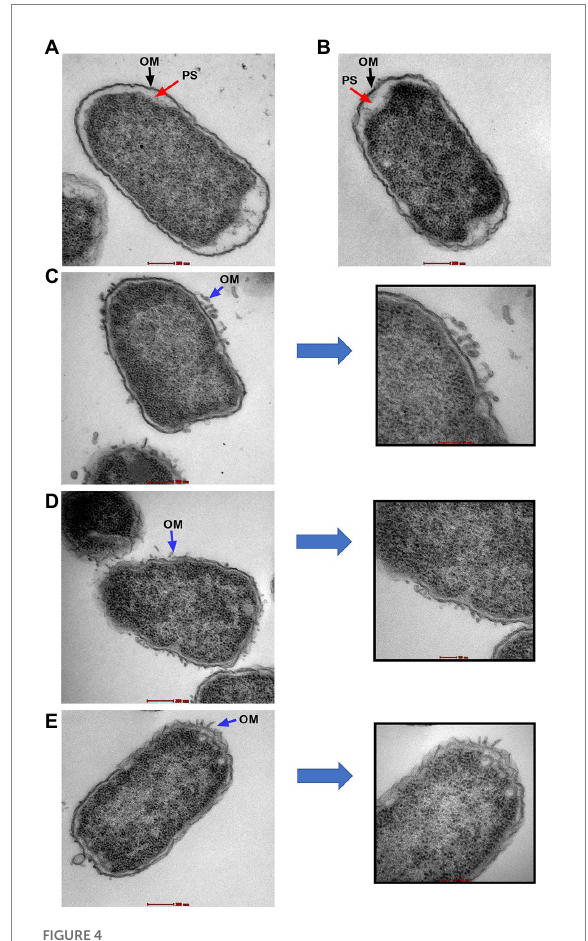
FIGURE 4 Transmission electron microscopy images of E. coli strain (EC26). Untreated cells (A) and cells treated with AZT—8 μ g/ml (B) , are shown with intact outer membrane (OM) and clear periplasmic space (PS). Damage to the OM was seen in bacterial cells treated with colistin—2 μ g/ml (C) , PMBN alone—16 μ g/ml (D) and PMBN—